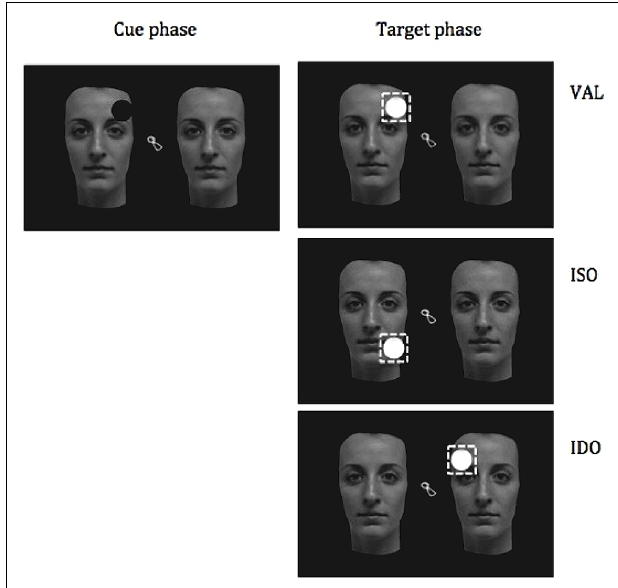
FIGURE 2 | Considering an example of the cue (originally colored of red) on the top of a left upright face, the figure shows the three possible locations of the target (originally colored of yellow) in the valid (VAL), invalid same-object (ISO), and invalid different-object (IDO) trials. The dashed square corresponds to the area of interest for each target.